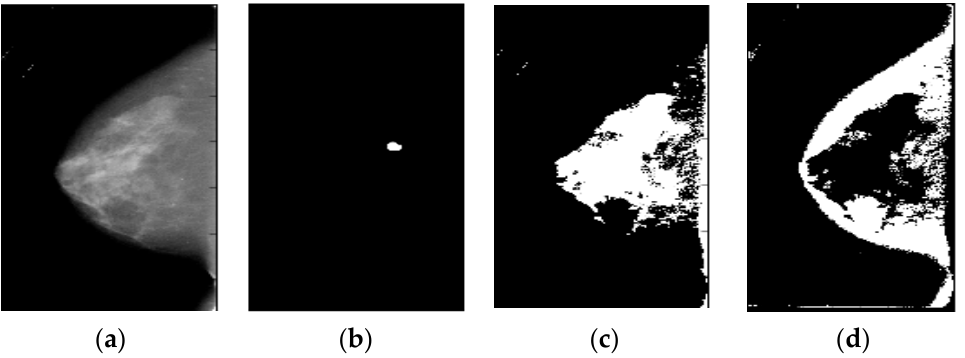
Figure 9. Mammography segmentation based on the multi-region approach at security level 1: ( a ) original image, ( b ) ground truth segmentation, ( c ) most important region, and ( d ) the second most important region.